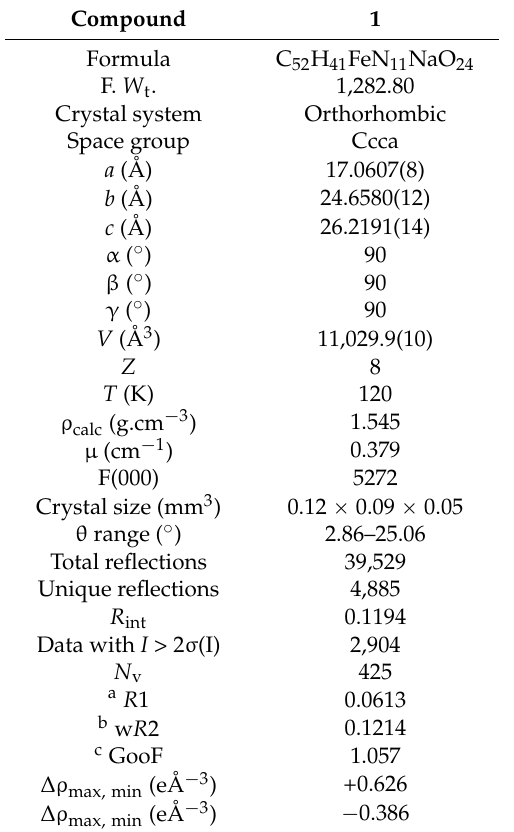
Table 1. Crystal data and structure refinement of compound 1